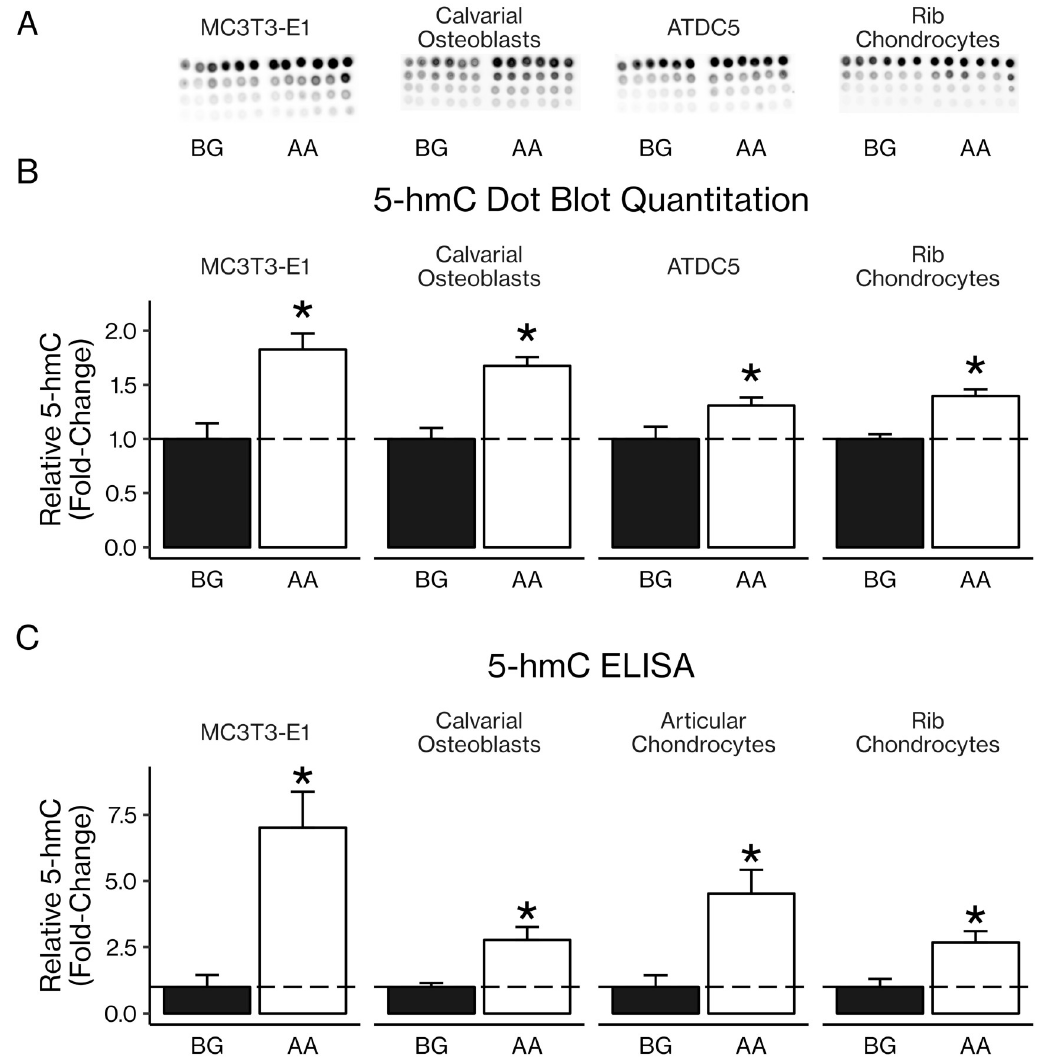
Fig 7. AA increased 5-hmC levels in osteoblasts and chondrocytes. (A) MC3T3-E1 pre-osteoblasts, primary calvarial osteoblasts, ATDC5 chondrocytes (not induced with, e.g., insulin and dexamethasone), and primary rib chondrocytes were treated with β -glycerophosphate (BG) with or without AA before DNA extraction and dot blotting using an antibody specific for 5-hmC. Each replicate is in a column on the dot blots, and each row indicates a serial two-fold dilution of the sample above it, beginning at 100 ng of DNA in each dot on the top row. (B) Dot blots were quantitated with ImageJ. (C) 5-hmC levels were also measured using an ELISA. Results are presented as mean fold-change ± SEM. � P < 0.05 (Student’s t -test), n = 6 per group for dot blot; technical issues during the ELISA led to several readings being invalidated, leaving the following n: MC3T3-E1 BG = 2, AA = 5; COB BG = 4, AA = 4; RC BG = 4, AA = 4; AC BG = 3, AA = 2.